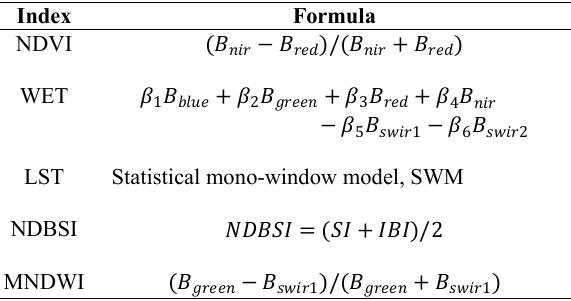
Table 1. NDVI, WET, LST, NDBSI, MNDWI calculation method.